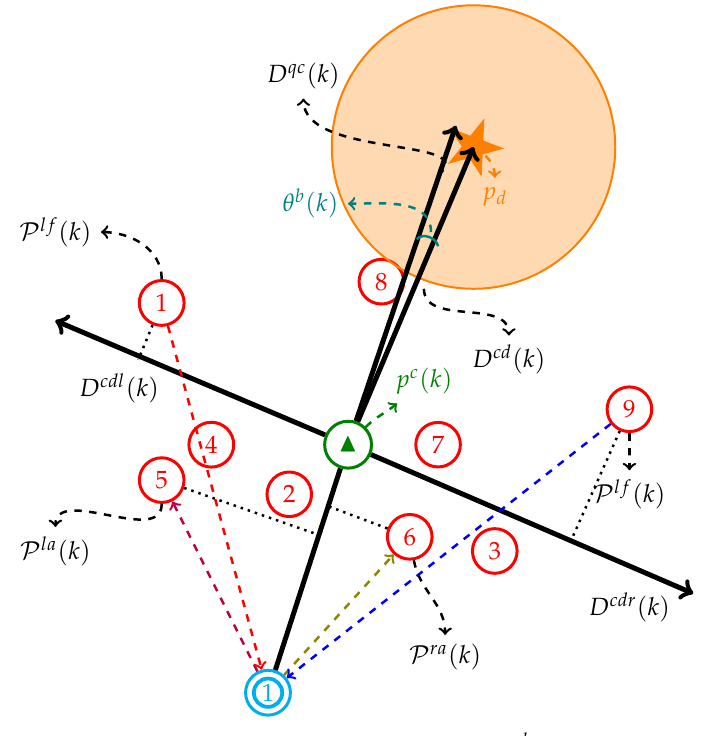
Figure 8. An example illustrating the definition of θ b ( k )